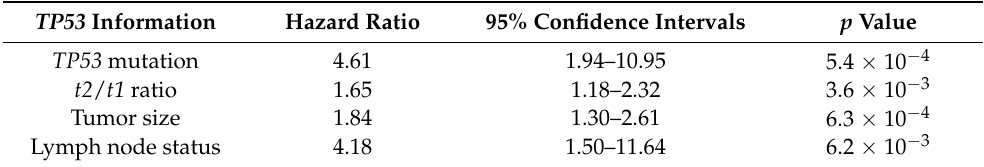
Table 3. Cox multivariable analysis of TP53 tumor information showing association with DMFS of patients with breast